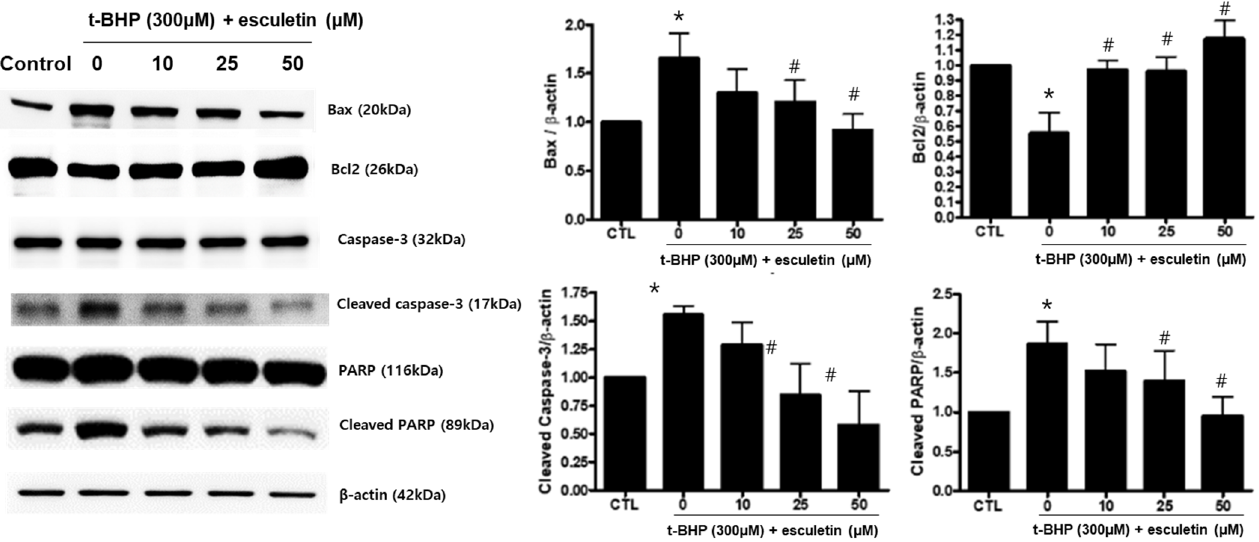
Figure 6. Effect of esculetin on the expression of apoptosis-related proteins in HEK293 cells. The protein expression levels of Bax, bcl-2, cleaved caspase-3 and cleaved PARP. In the bar graphs, the values represent means ± SD, n = 5. * p < 0.05 vs. untreated control group, # p < 0.05 vs. t-BHP-treated group.